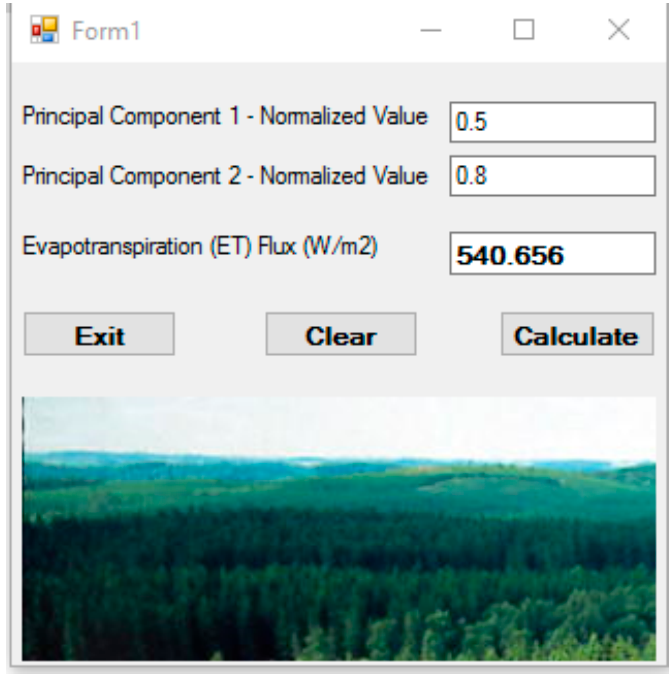
Figure A2. Executable file worked out example.